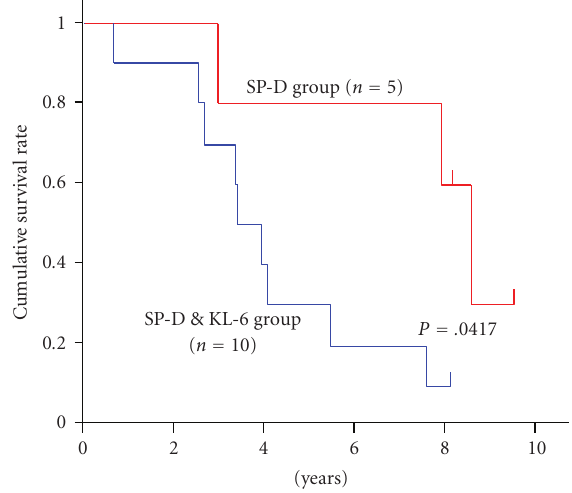
Figure 2: The Kaplan-Meier survival curves of patients with honeycombing in SP-D and SP-D&KL-6 groups. Patients in SP-D group (in red) had longer survival (mean survival time, MST; 3117 days) than those in SP-D&KL-6 group (in blue) (MST; 1232 days) ( P = .